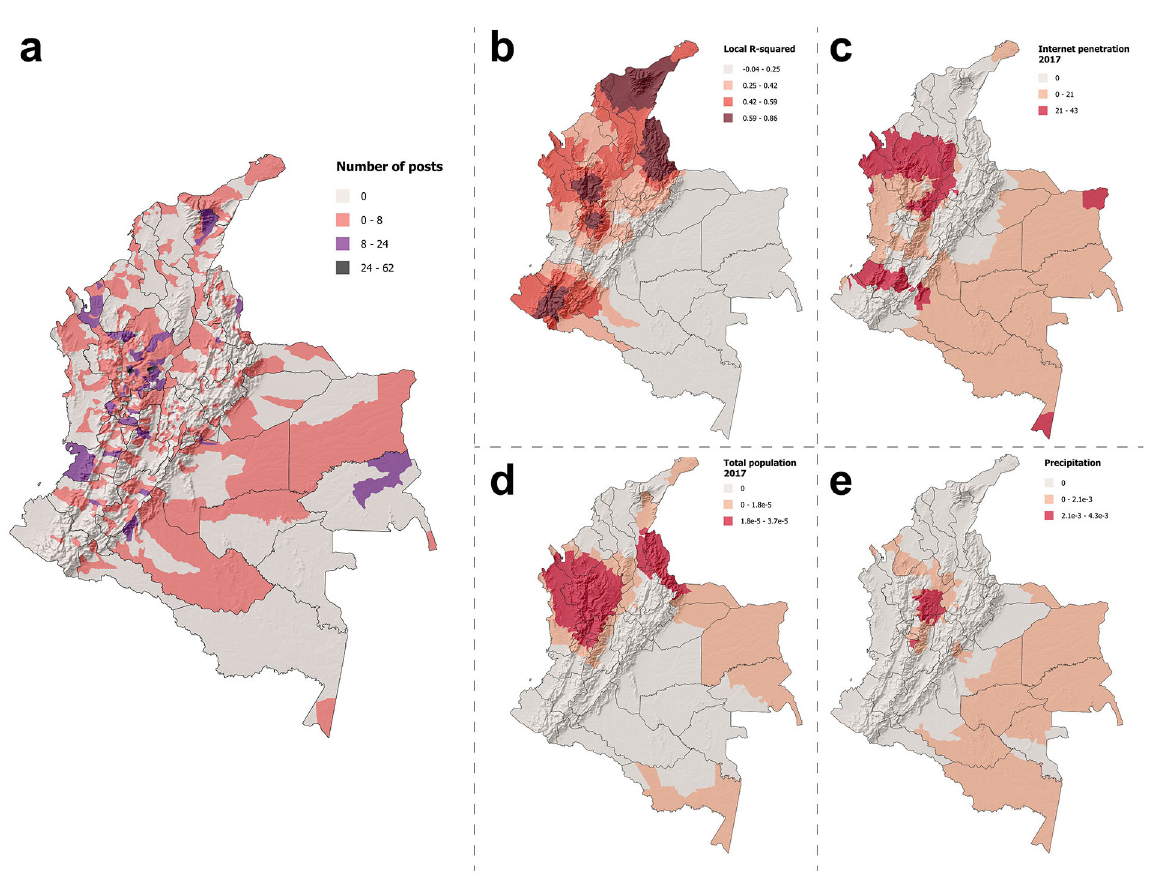
Figure 7. Data and estimates used in the GWR model. (a) Geographic distribution of posts. (b) Local R-squared for all municipalities. (c) Estimated slope for internet penetration. (d) Estimated slope for total population. I Estimates slope for